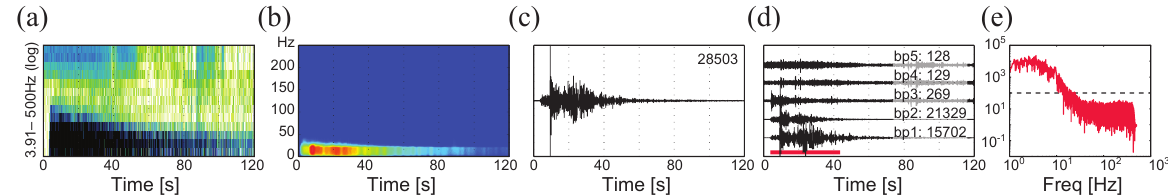
Figure 2. Seismic features of an earthquake displayed using different graphical representations. Regional event (110km in distance) from 30 June 2010, 11:53, with M L 4.3 at Saint-Jean-de-Maurienne, France. Recorded at SZ10, station S2.1 at t 0 30 June 2010, 11:54:00. (a) Sono- gram (logHz). (b) Spectrogram (0–250Hz). (c) Unfiltered seismogram (nms − 1 ). (d) Band-pass filtered seismograms (nms − 1 , bp1: 1–5; bp2: 5–20; bp3: 20–50; bp4: 50–100; and bp5: 100–200Hz). (e) Amplitude spectrum (FFT, nmHz − 1 ). A reference line at 100nmHz − 1 aids signal comparison. This layout is applied to all figures presenting the microseismic signals classification. Time indication is always UTC. Waveforms maximum absolute zero-to-peak amplitudes are indicated in nanometers per second above the seismograms in (c) and (d) . The signal window for which the FFT is computed is indicated by the red horizontal line in (d)